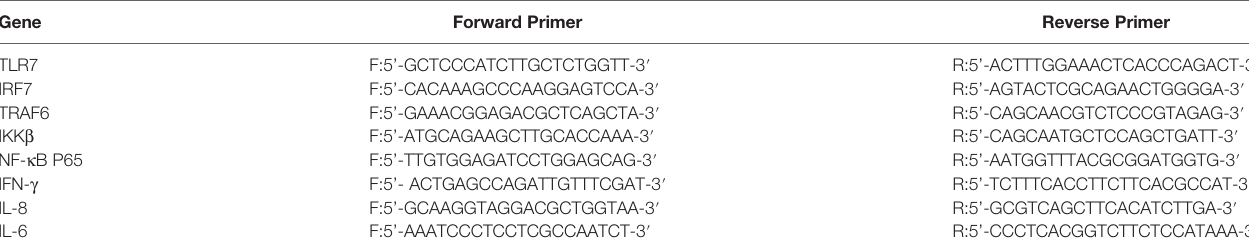
TABLE 1 | Real time -qPCR primers.